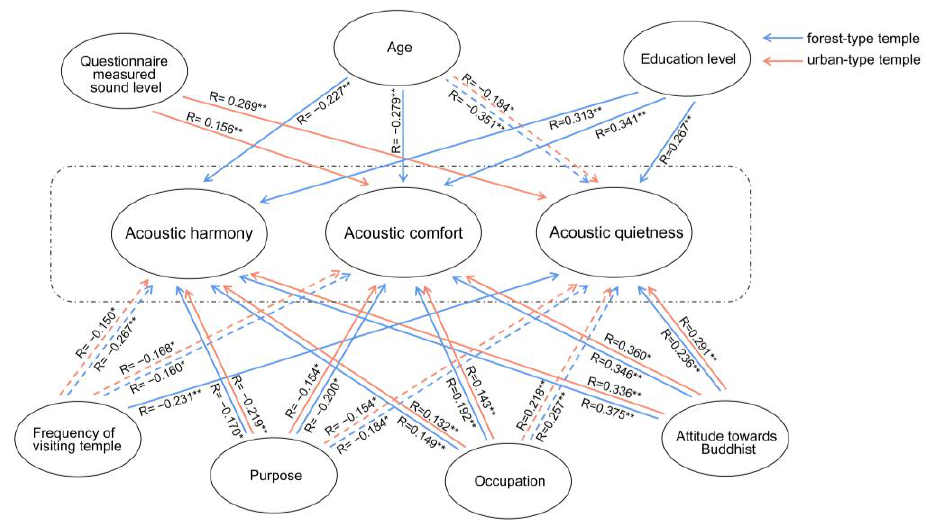
Figure 11. Schematic diagram of the influencing factors of three kinds of acoustic environment evaluations. Note: The double solid line indicates that certain people with the same characteristics have significant differences between the two types of temples, while the double dotted line indicates that people with the same characteristics have no significant differences between the two types of temples. In the figure, * and ** indicate significance level, * indicates p < 0.05, ** indicates p < 0.01.